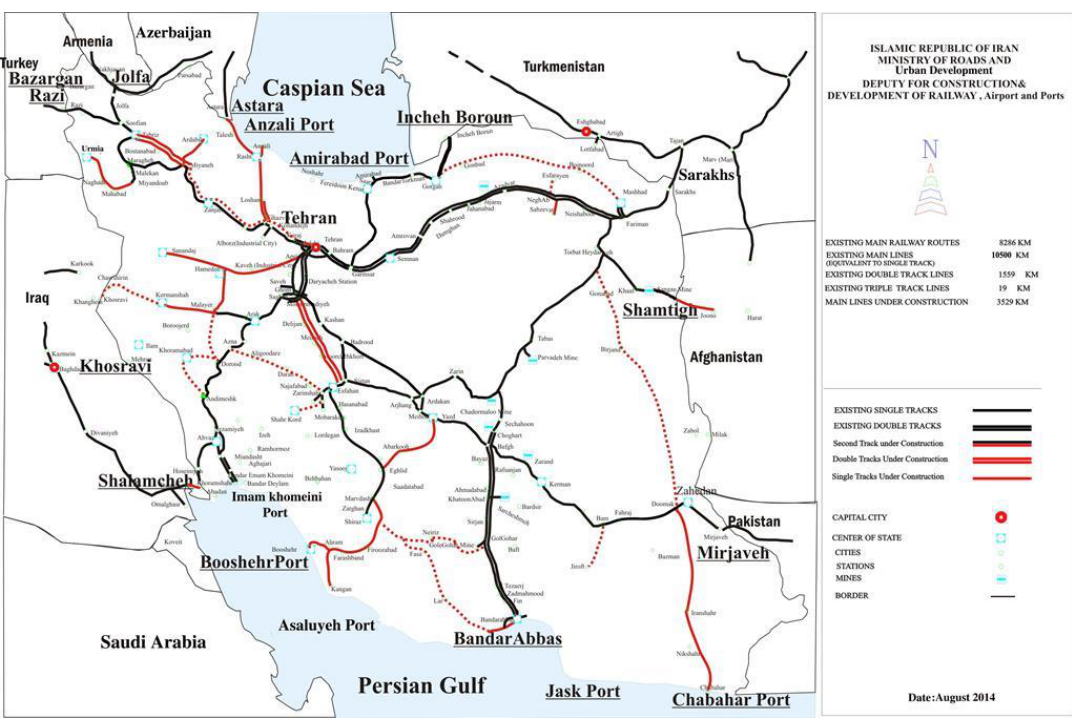
Figure1: Network map of Iran railroads